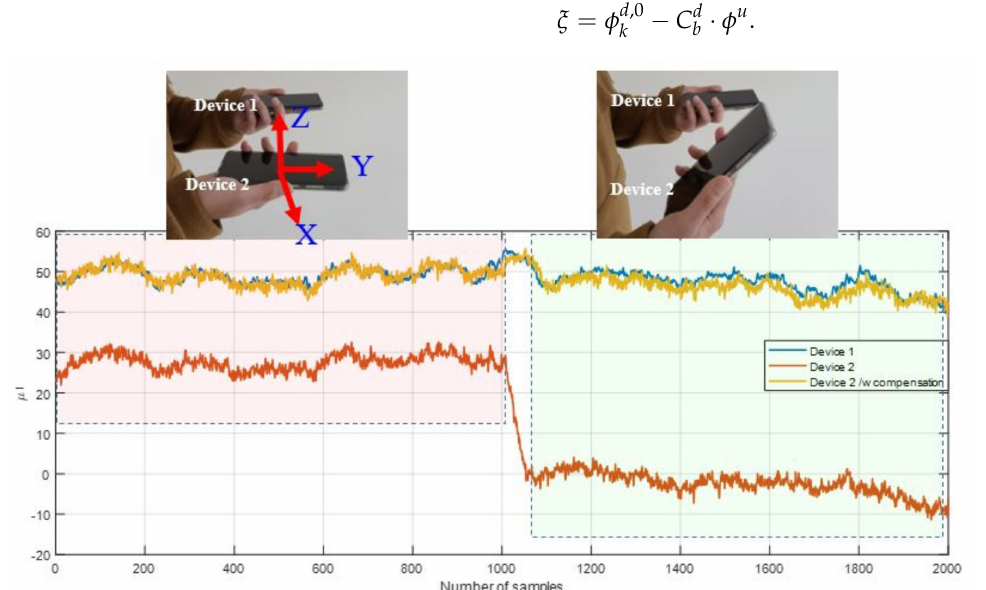
Figure 7. Indoor magnetic field values of two different smartphones. Magnetic sensor values were corrected through frame transformation and